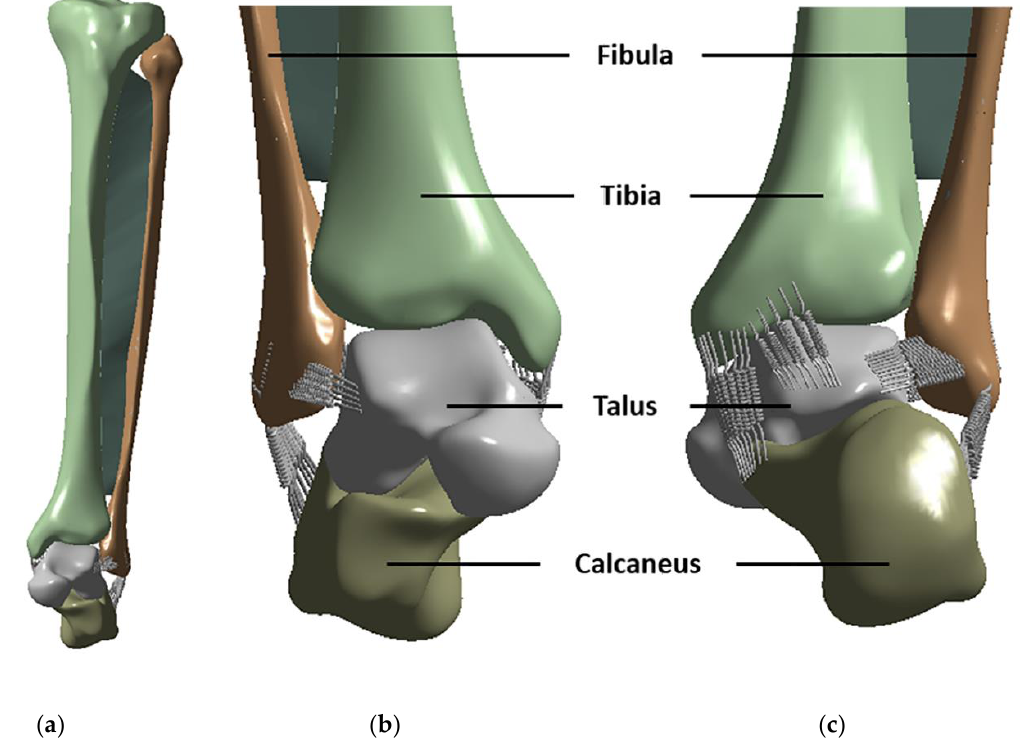
Figure 1. 3D models of the ankle bone and ligaments: ( a ) frontal view, ( b ) anterior ligaments, and ( c ) posterior ligaments.